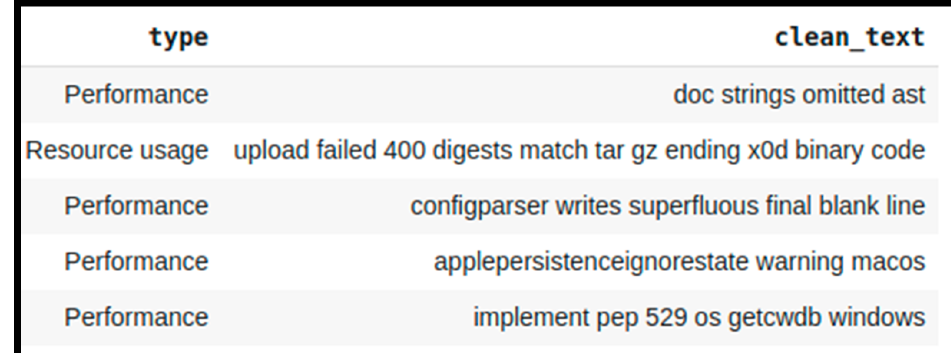
Figure 12. Dataset after case conversion.